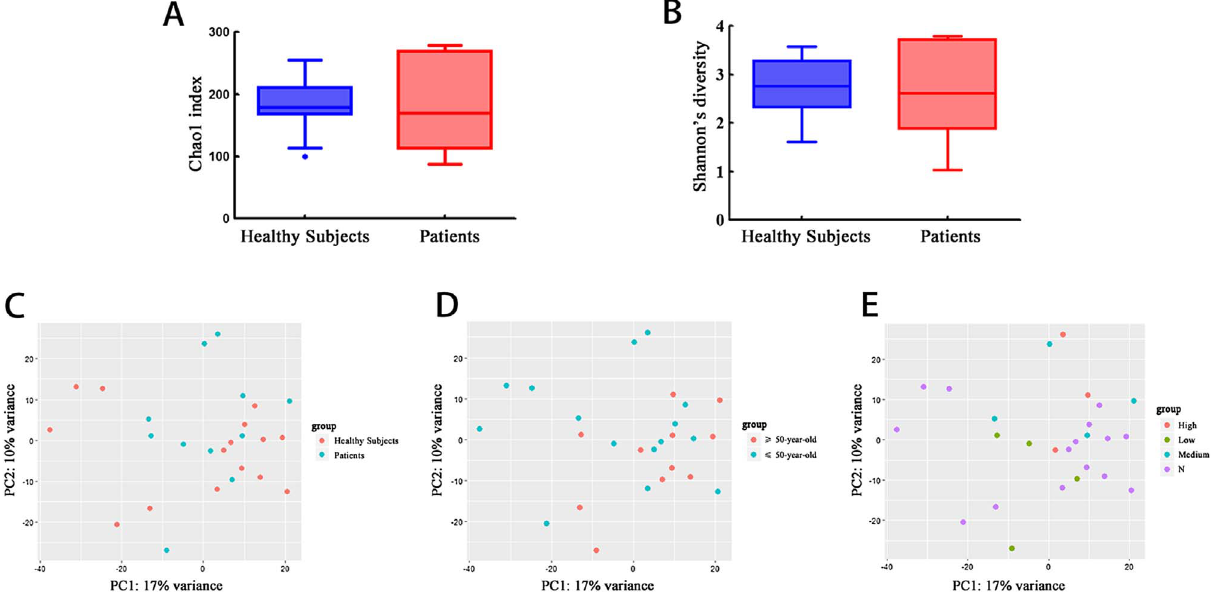
Figure 1. Relative abundance of bacterial phyla in infected patients ( n = 11) and healthy controls ( n = 15). (A) No signi fi cant differences were observed in the mean community richness as estimated by the Chao1 index. (B) No signi fi cant differences were observed in the mean community richness as estimated by the Shannon diversity index. (C) Principal coordinate analysis of the microbial communities in healthy controls and acute schistosomiasis patients using unweighted UniFrac distances by infection status (C), by age group (D), and indirect hemagglutination antibody (IHA) levels